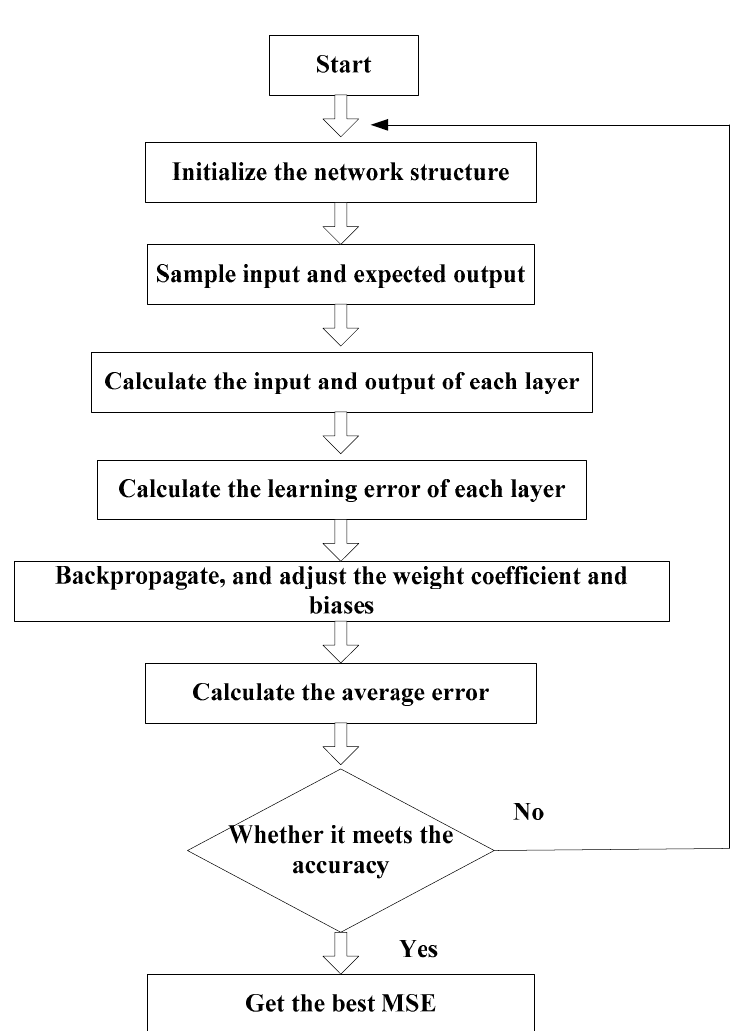
Figure 3. The flowchart of the outage probability (OP) performance prediction algorithm.